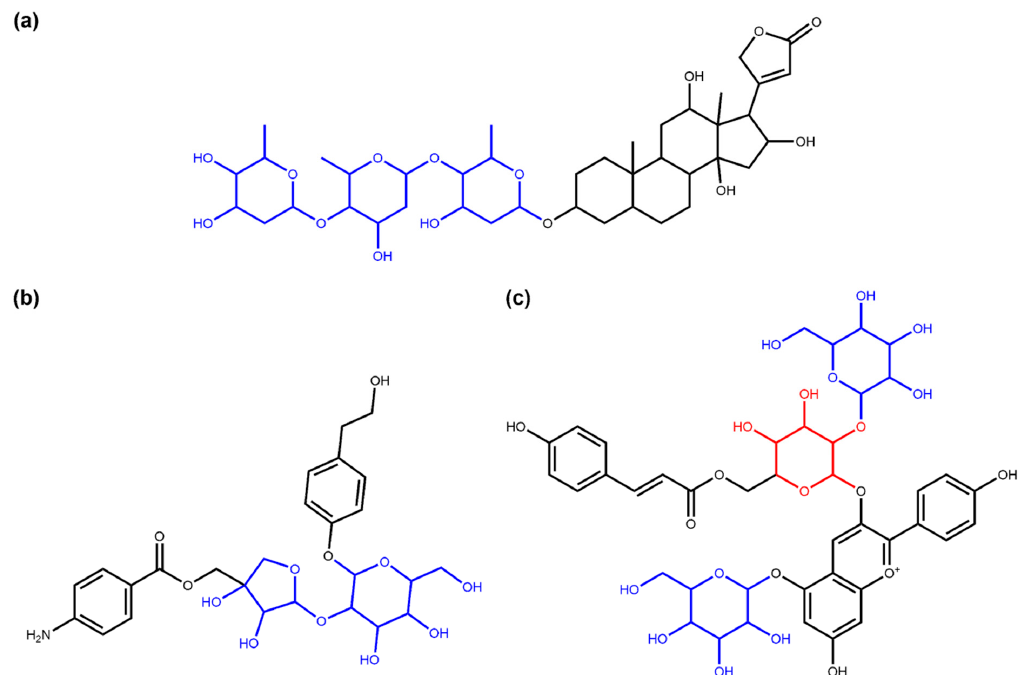
Figure 5. Examples of the terminal and non-terminal circular sugars identified in COCONUT NP. ( a ) Diginatin (COCONUT ID CNP0242430), a cardiac glycoside that has three terminal circular sugar moieties (in blue) ( b ) Cucurbitoside I (CNP0225316), a phenolic glycoside with two non-terminal circular sugars in its structure (in blue). ( c ) Pelargonidin-3-(2-Glucosyl-6-P-Coumarylglucoside)-5-Glucoside (CNP0028705), an anthocyanin [30] that contains both terminal (in blue) and non-terminal (in red) circular glycosidic moieties.